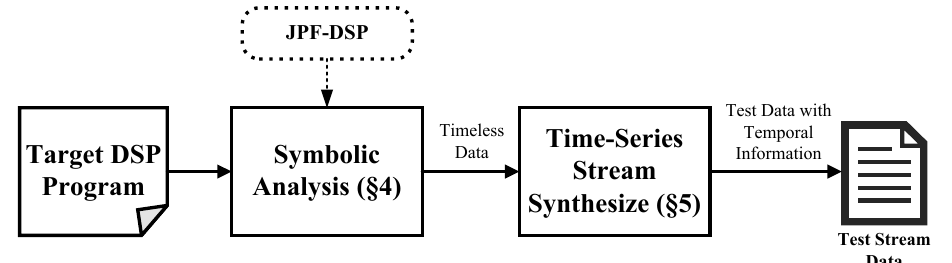
Figure 3. The framework for the comprehensive test